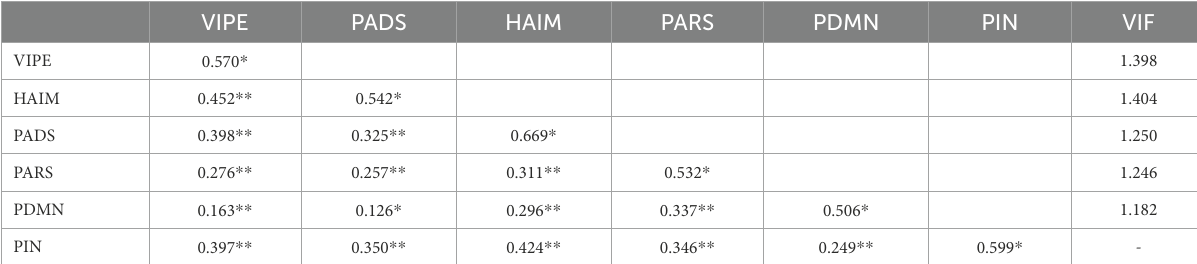
TABLE 5 Correlation analysis and discriminant validity test among